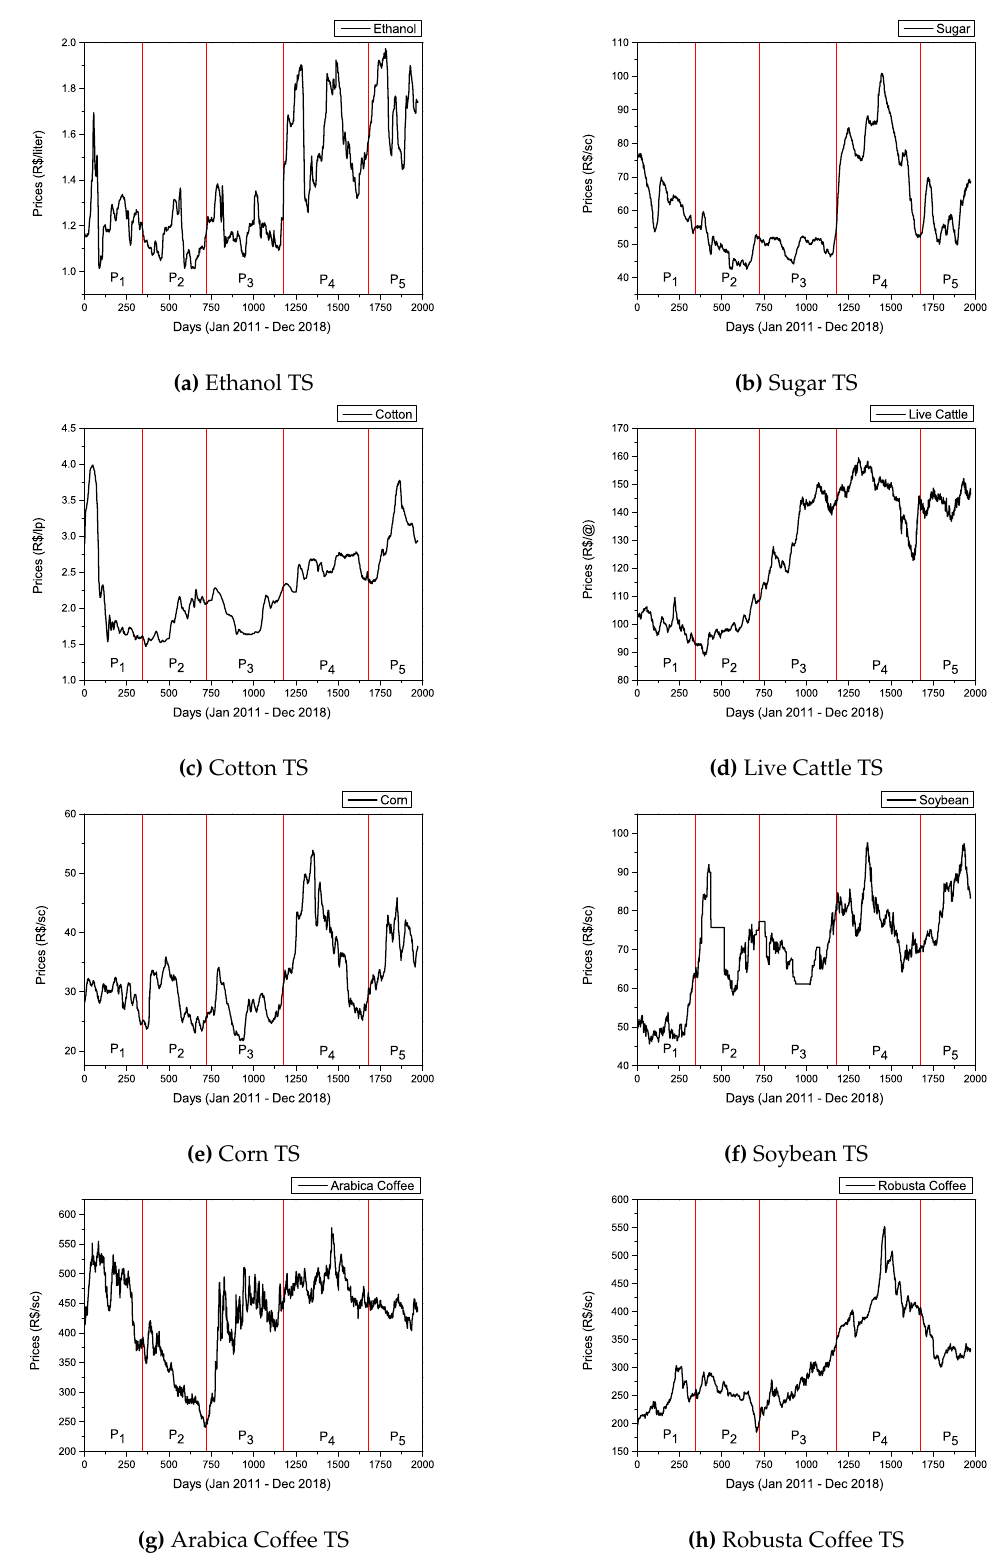
Figure 1. Spot prices time series (TS) of the eight commodities and the corresponding sub-periods P 1 to P 5